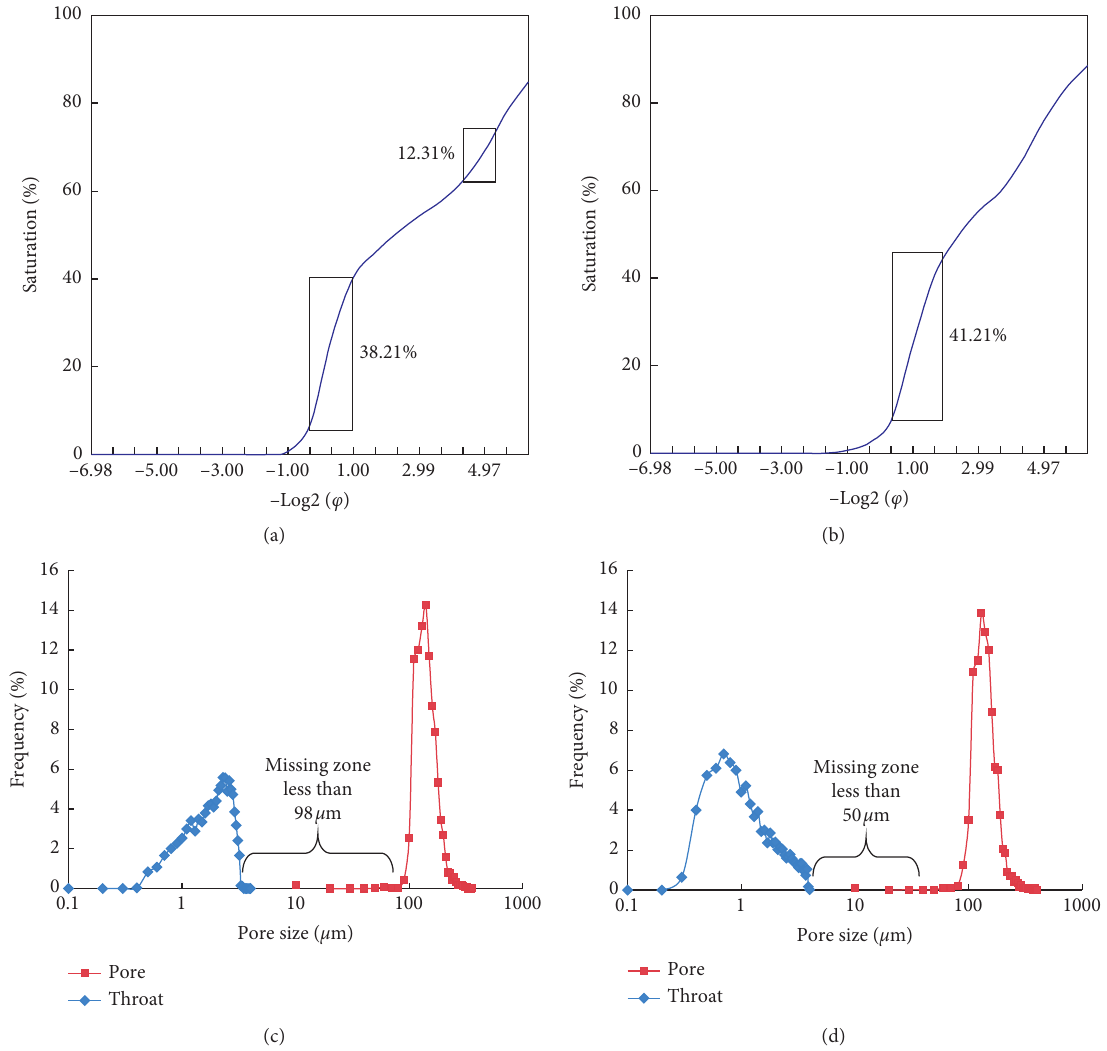
Figure 8: Cumulative pore size distributions from PCMI and RCMI.